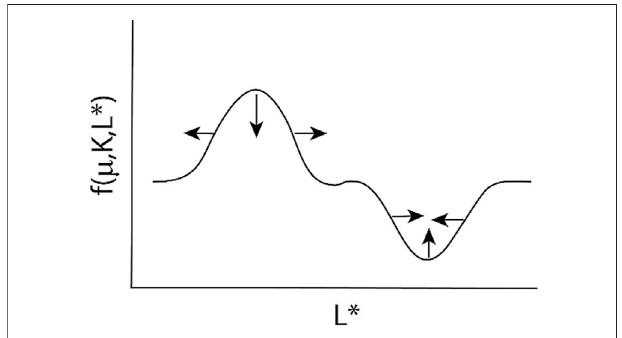
FIGURE 5 | Time evolution of a PSD described by a normal radial diffusion equation (from Green and Kivelson,